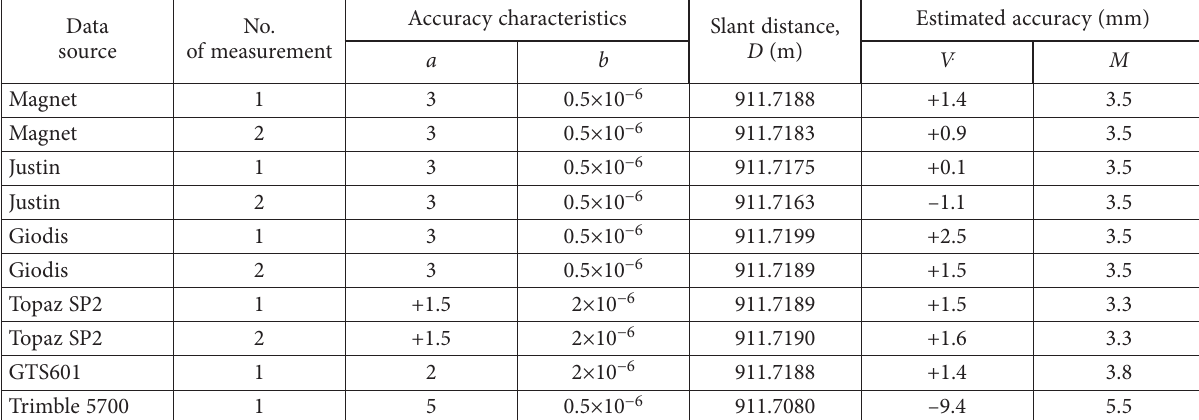
Table 2. Results of the